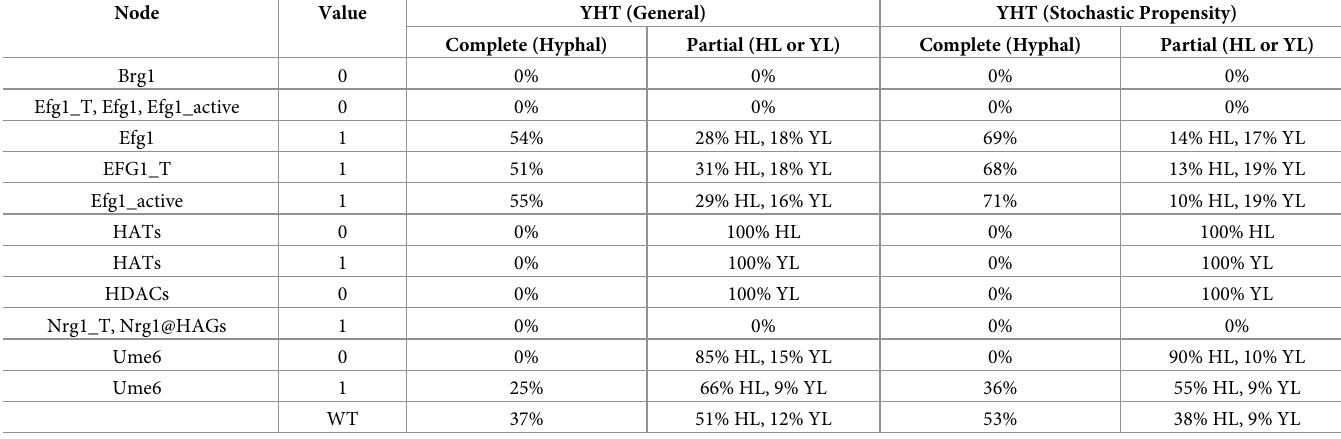
Table 4. Probabilities of completing the YHT in the condition pH = 1 and Farnesol = Temperature = 0, under single-node interventions or WT. Transition probabil- ities are estimated from 500 simulated trajectories starting from the yeast attractor corresponding to the given environment (see Fig 2). When a perturbed system’s attractor is different from the WT attractor, it is classified into a phenotype (attractor group) by similar criteria as in Fig 2; see S2 Fig for more details.